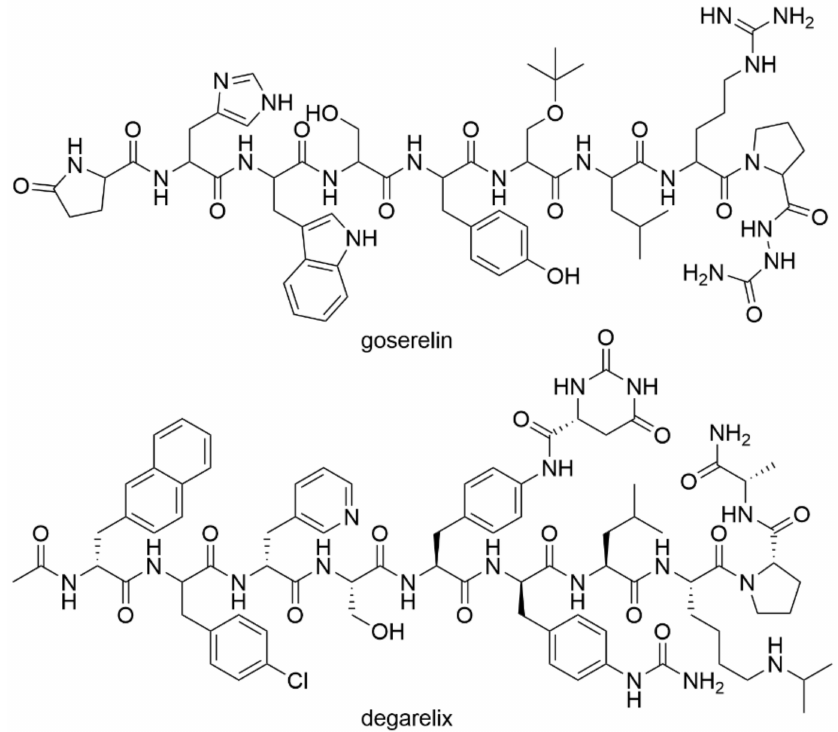
Figure 4. Chemical structures of agonists and antagonists of luteinizing hormone-releasing